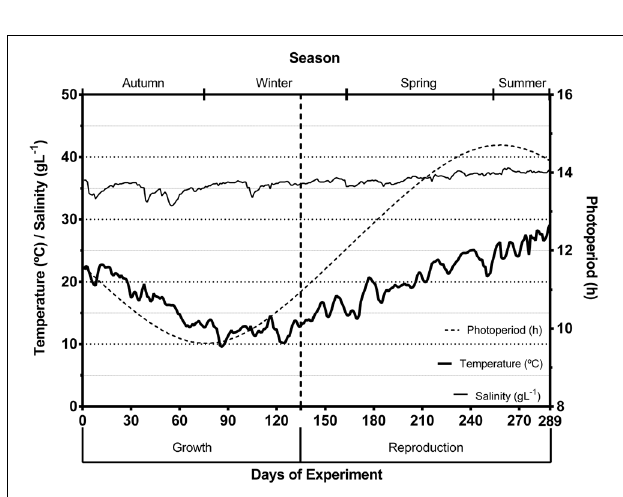
FIGURE 2 | Temperature ( ◦ C), salinity (gL - 1 ) and photoperiod (hours of light) throughout the different stages (bold vertical dash line) and seasons of the breeding stocks of cuttlefish S. officinalis . Temperature and salinity values are a mean of all tanks under